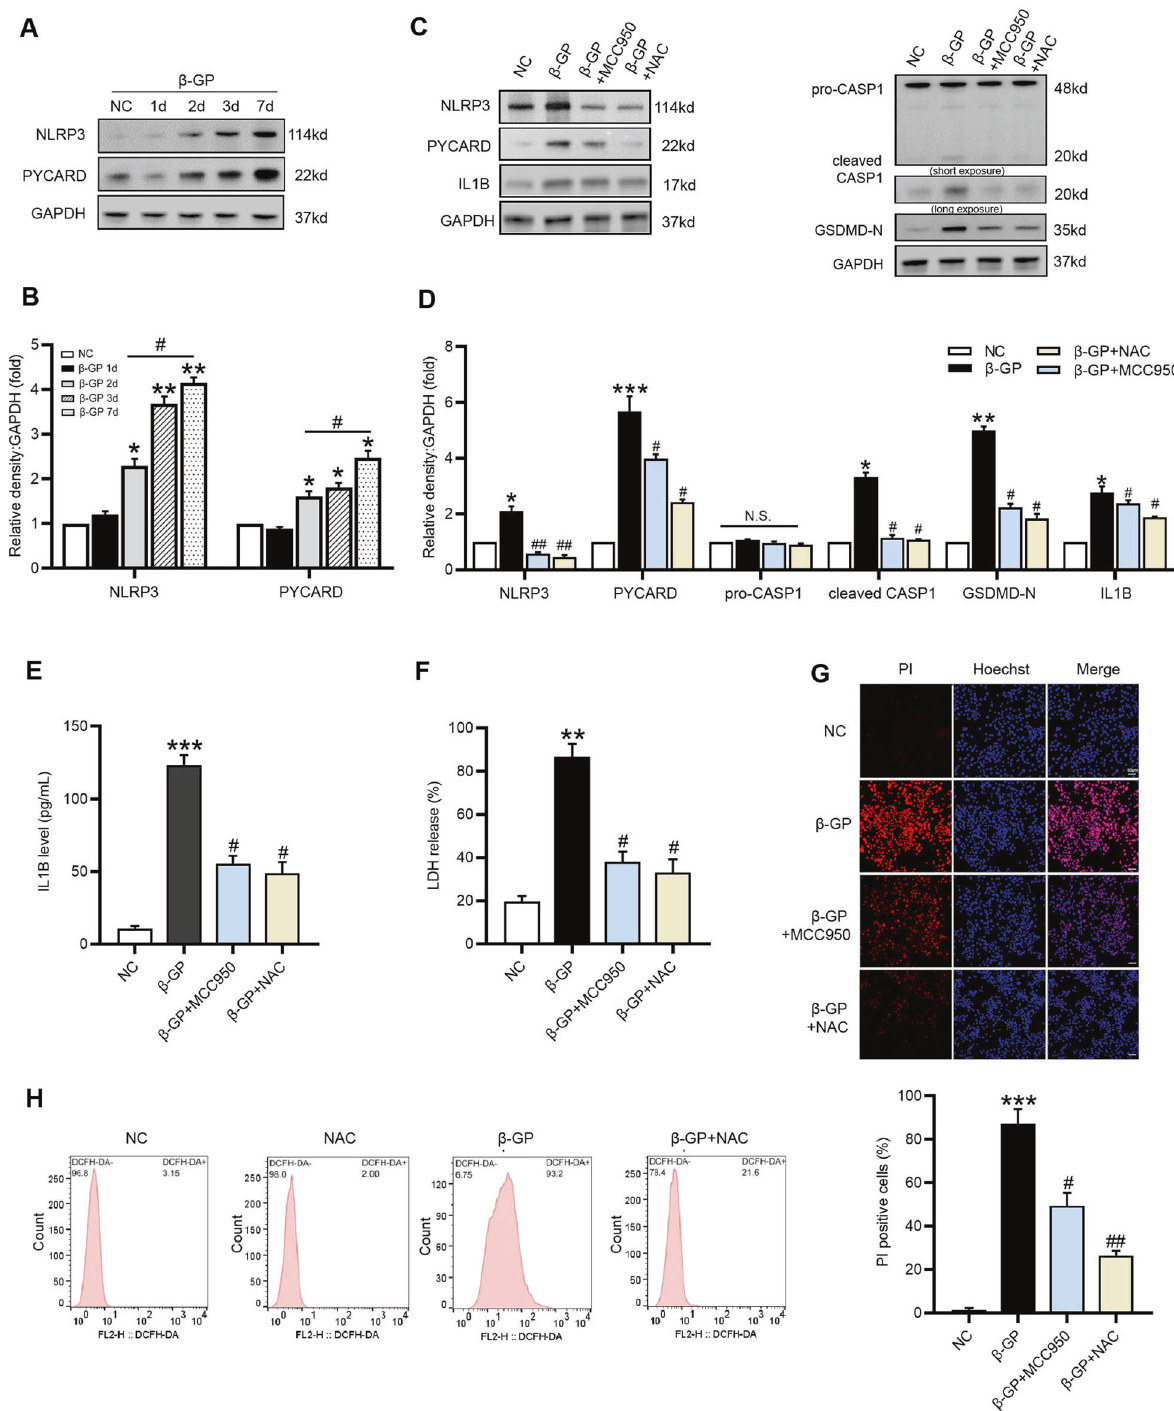
Fig. 3 ROS-mediated NLRP3 in fl ammasome activation is involved in β -GP-induced VSMC pyroptosis. VSMCs were treated with β -GP (10 mM) for the indicated time. A The protein levels of NLRP3 and PYCARD were determined by western blotting. B Quanti fi cation of the results shown in A . The data are presented as means ± SEM. *P < 0.05, **P < 0.01 vs. control group; # P < 0.05, ## P < 0.01 vs . indicated group. VSMCs were incubated in the presence of β ‐ GP (10 mM) medium with the ROS inhibitor NAC (20 μ M) or NLRP3 inhibitor MCC950 (100 μ M) as indicated. C The protein levels of pyroptosis-related markers were determined by western blotting. D Quanti fi cation of the results shown in C . E The IL1B content in VSMC culture supernatants was determined by ELISA. F The release of LDH was detected using the LDH Assay Kit. G The percentage of PI-positive cells was measured using Hoechst 33342 (blue)/PI (red) double staining (top: Representative images; bottom: Quantitative analysis of PI-positive cells). Scale bar = 50 μ m. H The intracellular ROS level was detected using the fl uorescent probe DCFH-DA and measured by fl ow cytometry. Data are expressed as mean ± SEM. *P < 0.05, **P < 0.01, ***P < 0.001 vs. control group; # P < 0.05, ## P < 0.01 vs. β -GP group; and N.S. not signi fi cant.